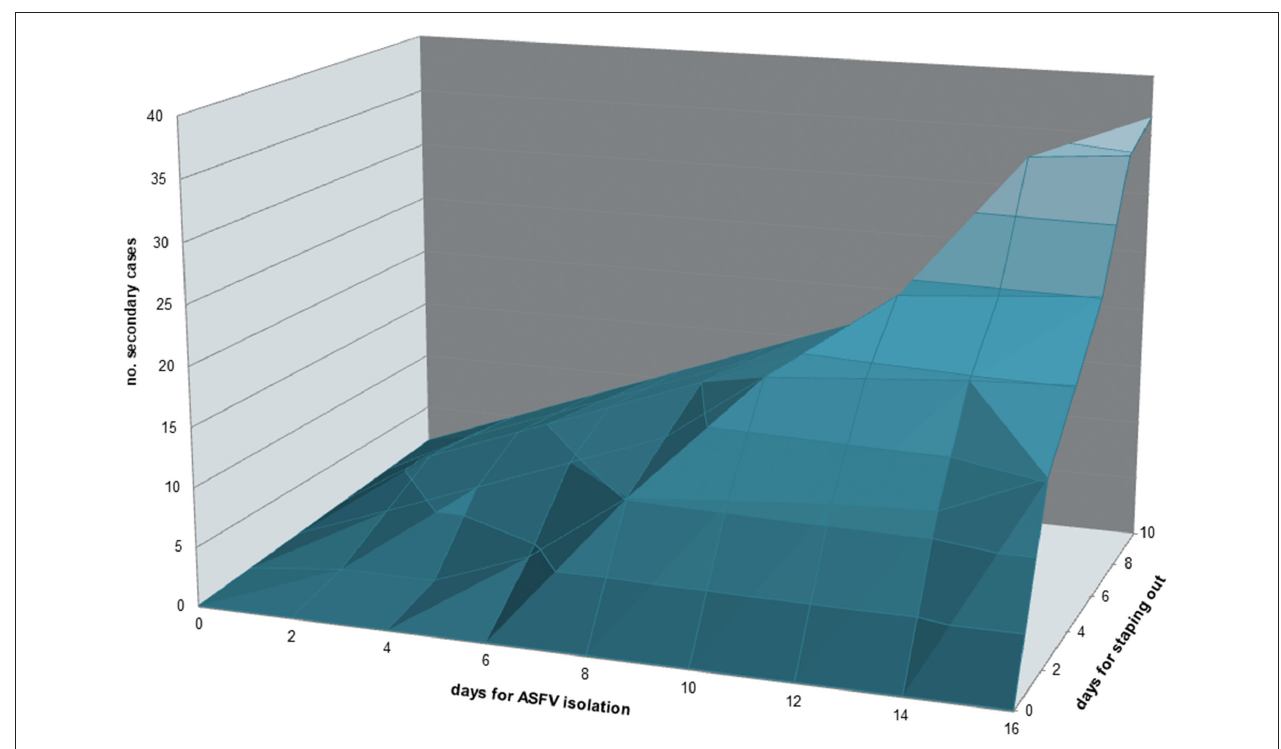
FIGURE 7 | Contour plot representing the relation between time (days) used for ASFV isolation and time (days) used for stamping out in the primary outbreak with the number of secondary cases associated.